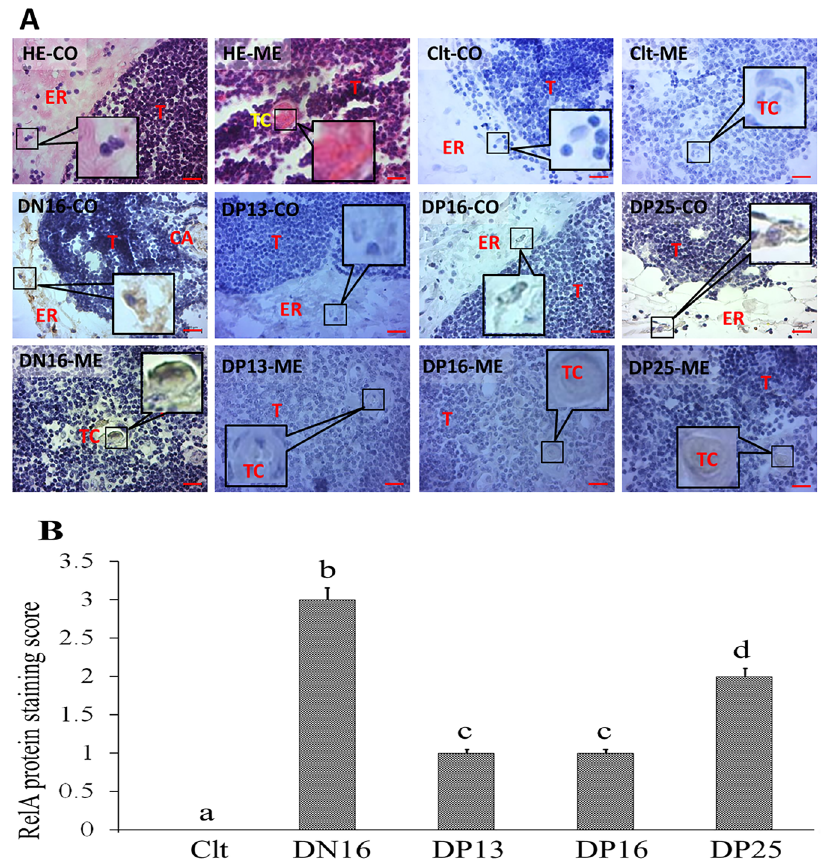
Figure 3. Localization of RelA protein in the thymus. ( A ) Representative immunohistochemical localization of RelA protein in the thymus from non-pregnant and pregnant ewes (n = 6 for each group). The thymus is divided into the cortex (CO) and the medulla (ME). Note: HE = stained by haematoxylin and eosin; Ctl = negative control; DN16 = day 16 of the estrous cycle; DP13 = day 13 of pregnancy; DP16 = day 16 of pregnancy; DP25 = day 25 of pregnancy; T = thymocyte; ER = epithelial reticular cell; CA = capillary; TC = thymic corpuscle. Bar = 20 µm. ( B ) Staining score for RelA protein. Significance is denoted by letters; if two groups have different letters, this indicates that the difference between these groups was significant with P <